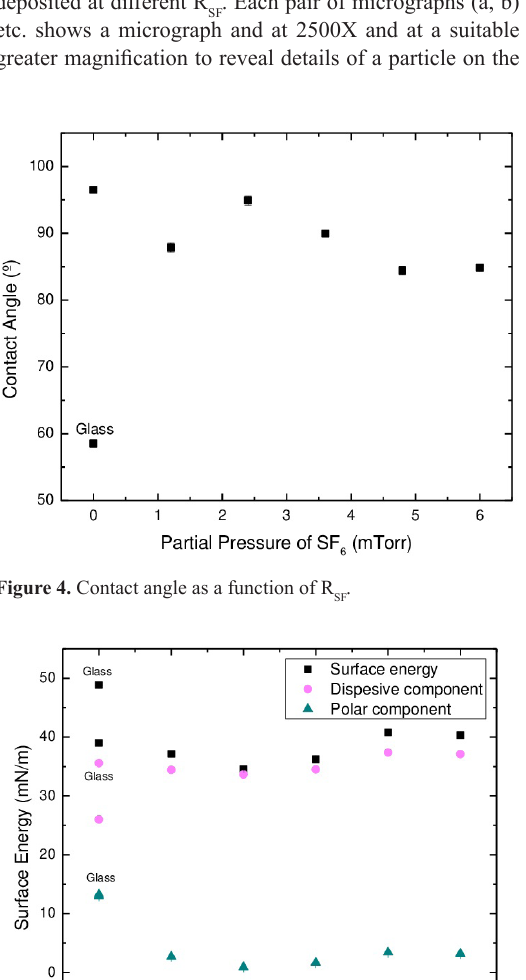
Figure 5. Total surface energy, polar, and dispersive components as a function of R . SF SF